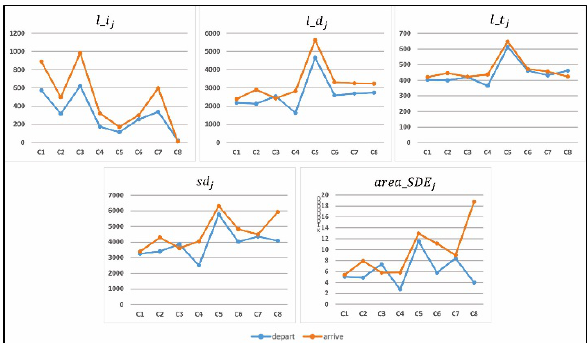
Figure 6. Statistical values of the clustering patterns Compared to ordinary communities, the intensity